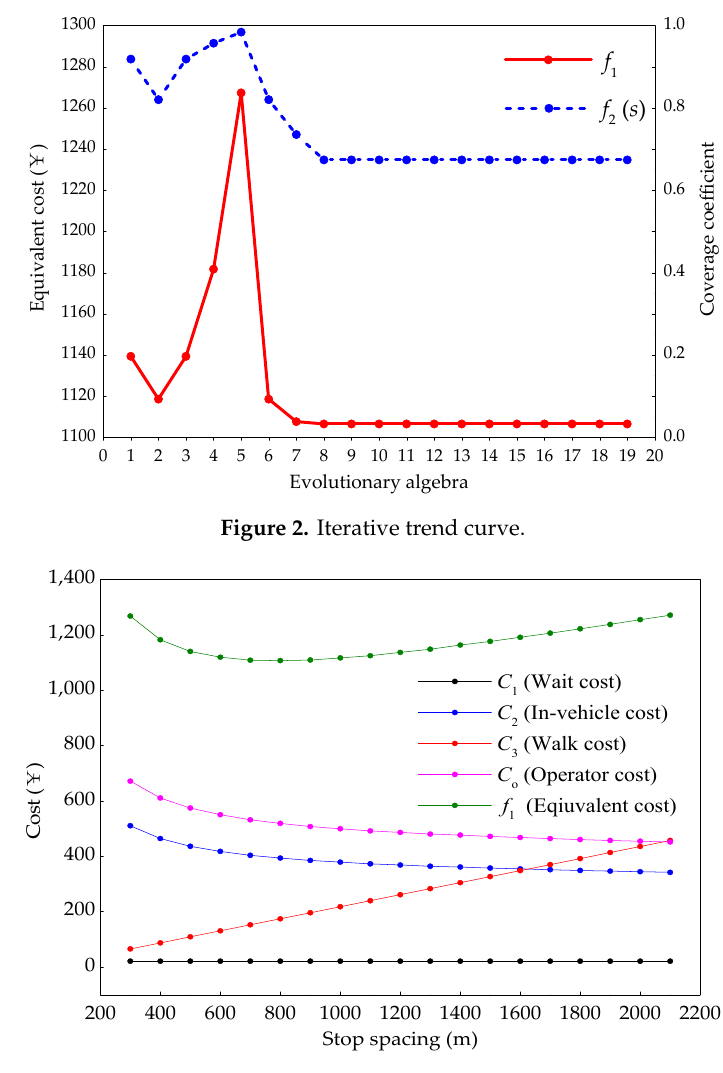
Figure 3. Different costs versus stop spacing. Figure 3. Di ff erent costs versus stop